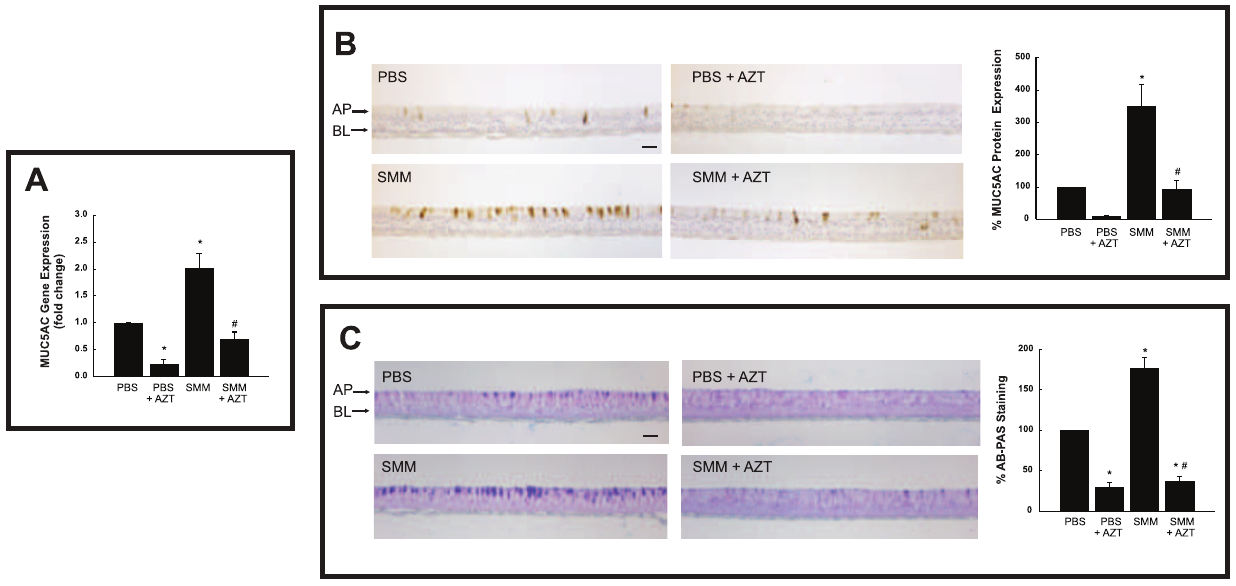
Figure 5. AZT decreases basal and SMM-stimulated mRNA and protein expression levels of MUC5AC in human airway epithelia. Well-differentiated HBE were exposed for 24 hr to mucosal PBS or mucosal SMM in the absence of presence of 72 hr pretreatment with 30 m g/ml serosal AZT. A: MUC5AC mRNA levels, expressed as fold change from mucosal PBS-exposed HBE. B: Immunocytochemical assessment of MUC5AC in HBE. Right panel depicts compiled data from MUC5AC expression as a percent of PBS-exposed HBE. C: AB-PAS staining from HBE subjected to the various treatments. Right panel shows compiled data from AB-PAS staining as a percent of PBS-exposed HBE. *p , 0.05 vs. PBS-exposed HBE; # p , 0.05 SMM + AZT-exposed HBE vs. SMM-exposed HBE.